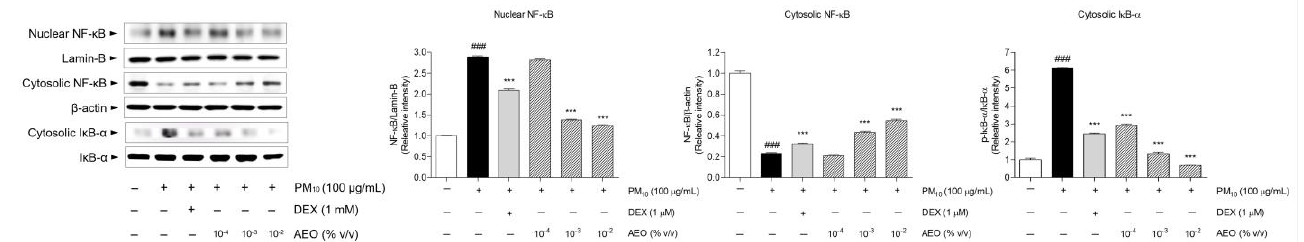
Figure 8. AEO regulated expression levels of NF- κ B signaling pathways on PM 10 -induced human nasal epithelial cells. The protein levels of nuclear NF- κ B, cytosolic NF- κ B, and cytosolic I κ B- α were analyzed by western blot assay. The data are presented as the means ± standard error of the mean. ### p < 0.001 compared to the NOR group. *** p < 0.001 compared to PM 10 -treated group.